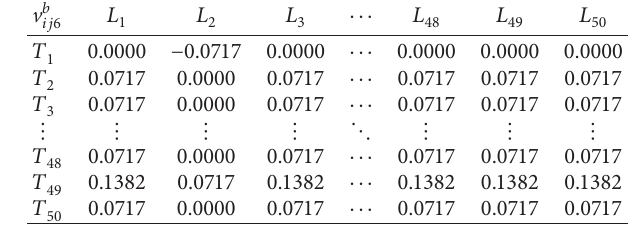
Table 34: Perceived utility matrix V b ′ � [ d ij ′ ] for 6 6 50 × 50 housing decoration